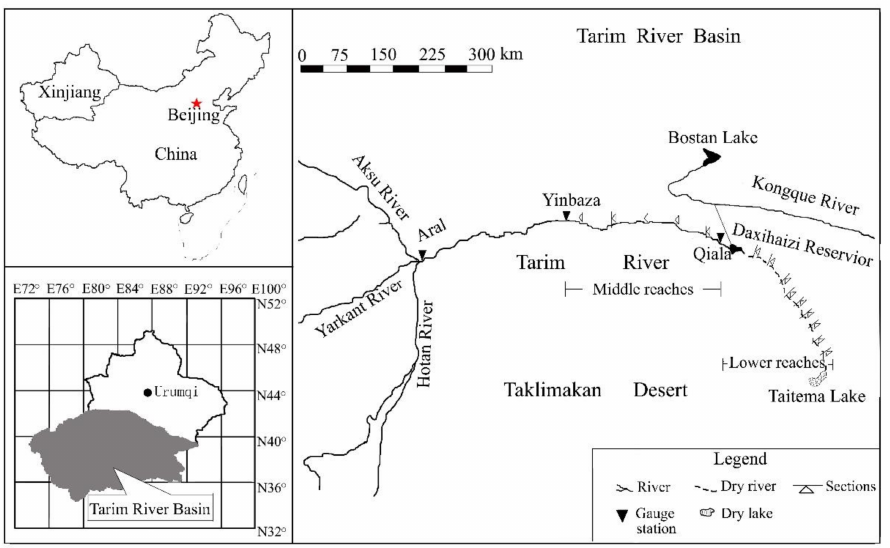
Figure 1. Sketch of the study